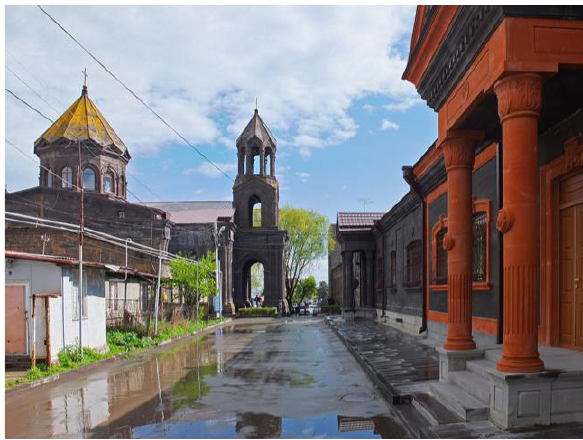
Figure 22. Single-storey houses with red tuff details, built in the 2010s, subordinate to the height of the Church of the Holy Mother of God. Photo by the author, 2019.